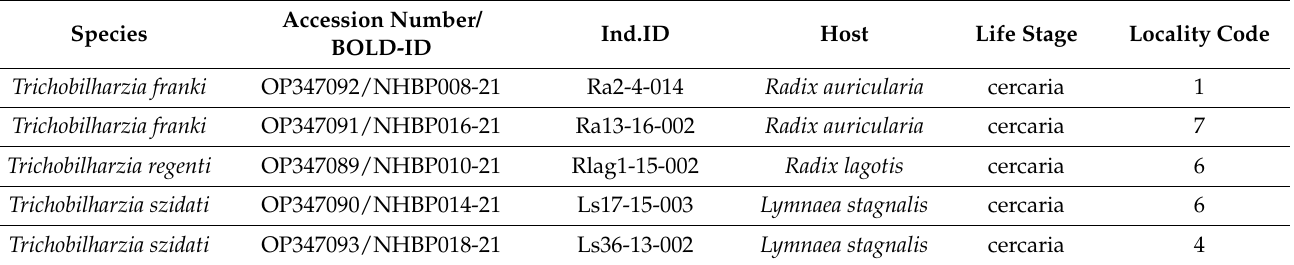
Table 2. List of cercariae analysed genetically and their snail host species. The locality numbers correspond to those in Table